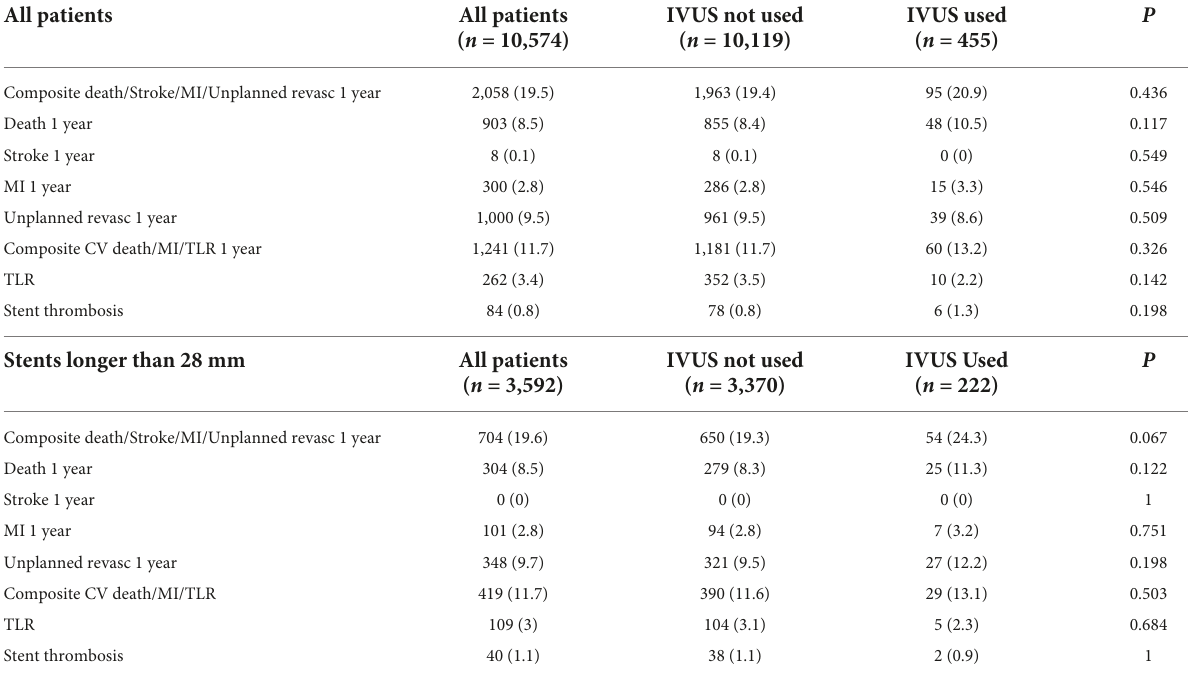
TABLE 3 Unadjusted outcomes.